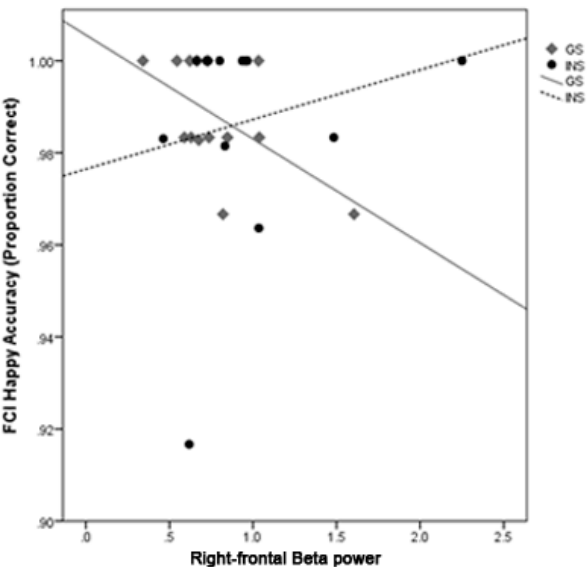
Figure 2. The correlations between right-frontal beta power and accuracy for Happy faces on the FCI for GS and INS groups. A night of greater right-frontal beta activity was associated with lower accuracy for the GS